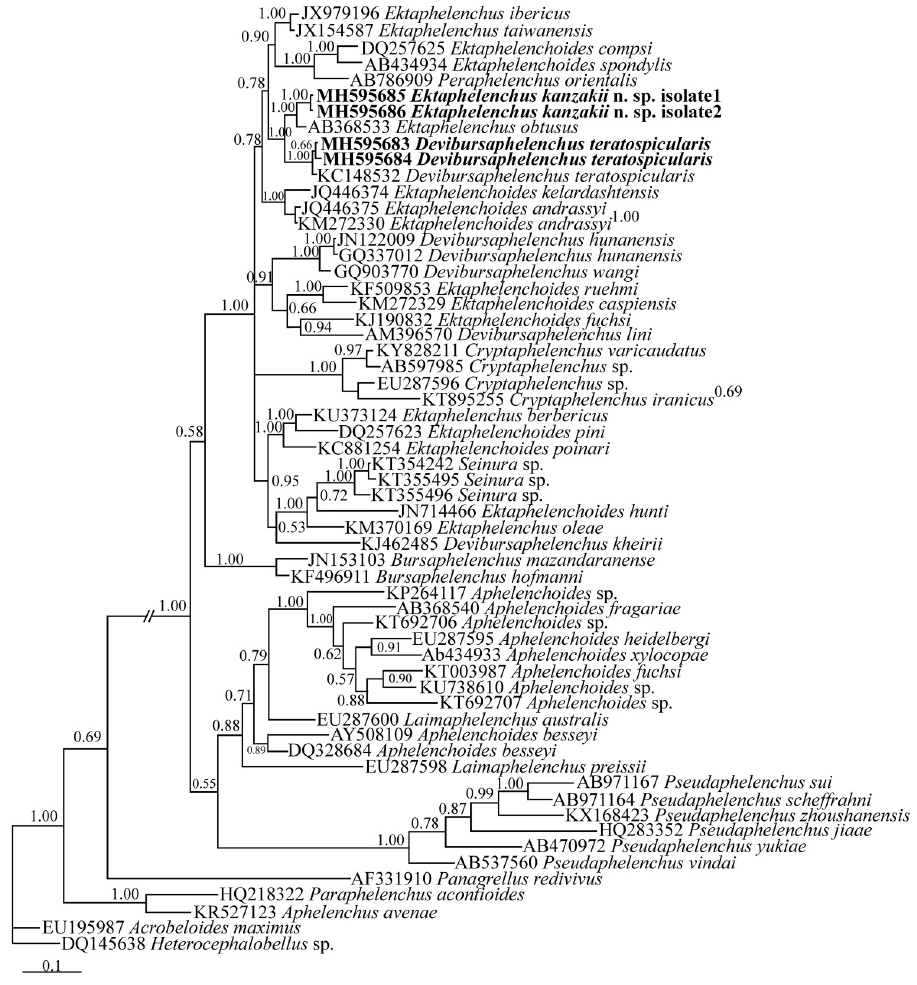
Fig 5. Bayesian 50% majority rule consensus tree inferred from LSU rDNA D2-D3 of Ektaphelenchus kanzakii n. sp. and Iranian population of Devibursaphelenchus teratospicularis Kakulia & Devdariani, 1965 [13] under the GTR + G + I model. Bayesian posterior probabilities (BPP) more than 50% are given for appropriate clades. New sequences are in bold